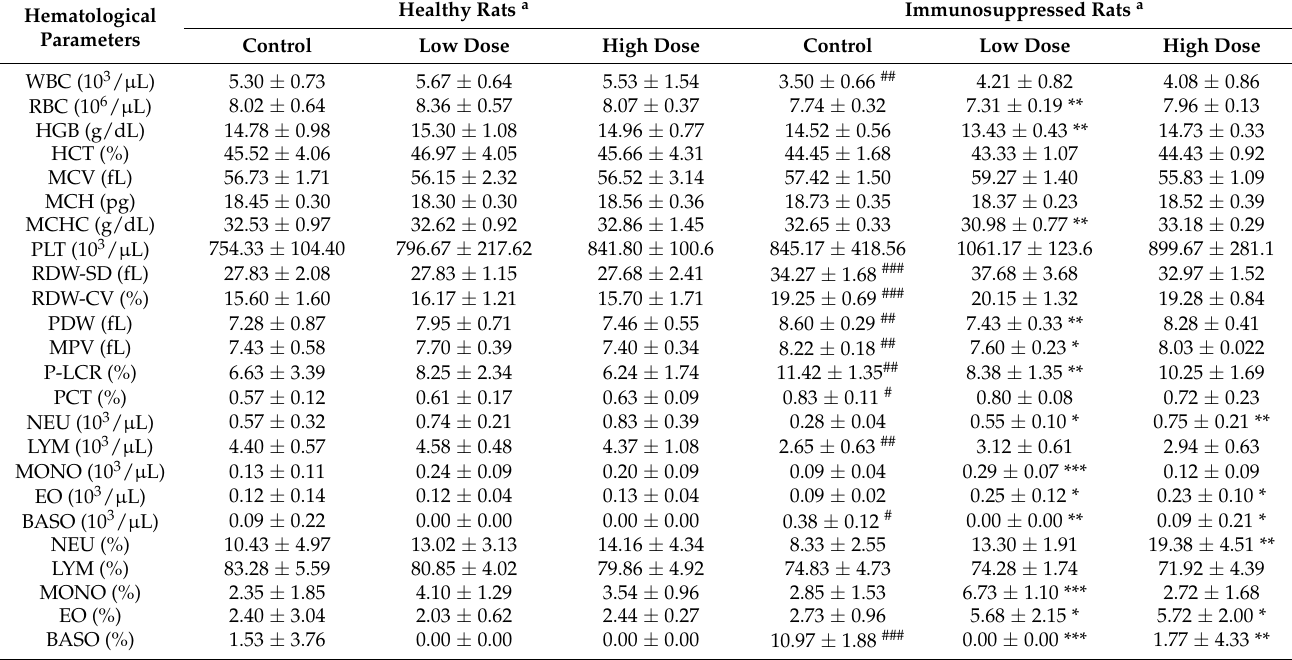
Table 4. Effect of HCFP on hematological parameters in healthy and cyclophosphamide-induced immunosuppressed rats. Hematological